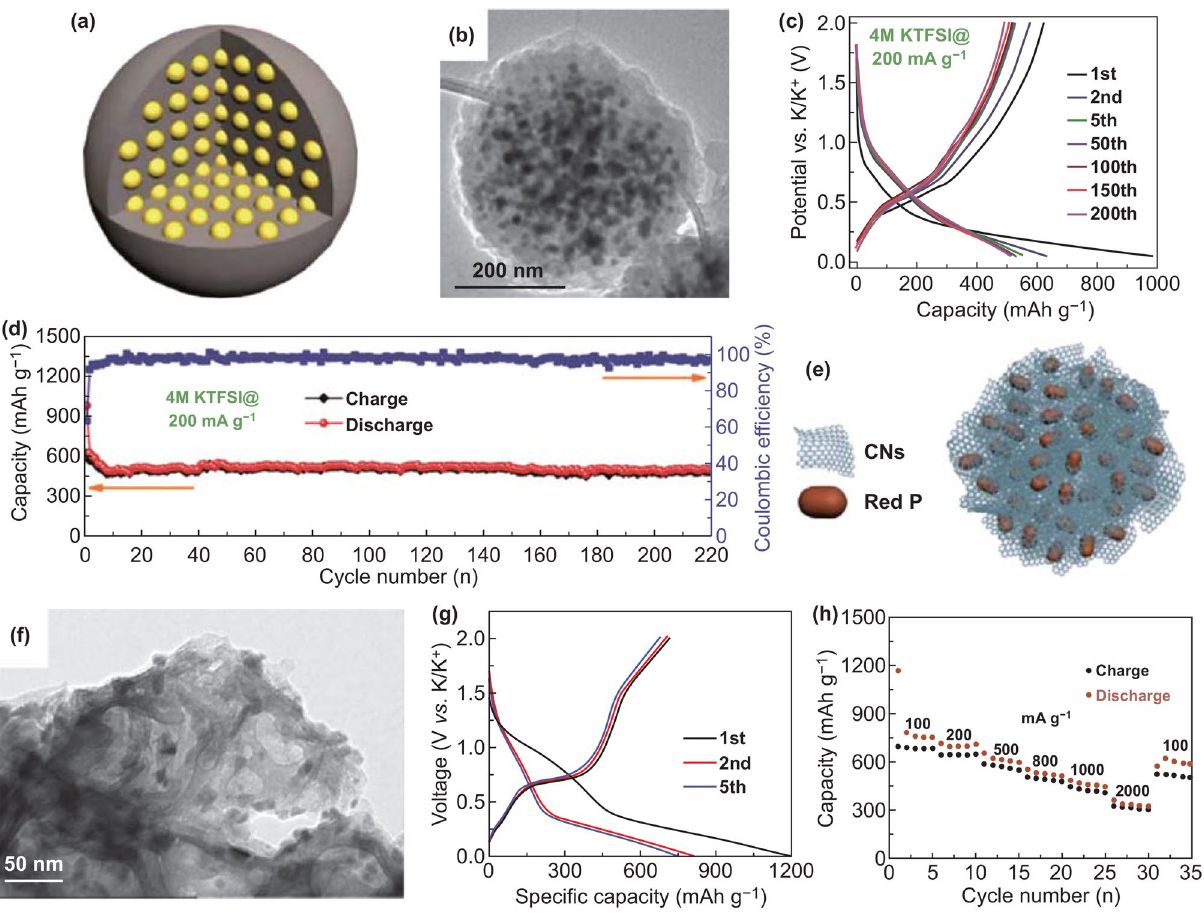
Fig. 5 a Sb@CSN’s schematic diagram. b Single Sb@CSN sphere exhibited in TEM image. c Voltage profiles as well as d Related cycle capacities of Sb@CSN at 200 mA g −1 . Reproduced with permission from Ref. [90]. Copyright 2019, Royal Society of Chemistry. e Schematic illustration of red P@CN composite. f TEM image of red P@CN composite. g Voltage curves of red P@CN composite for the selected